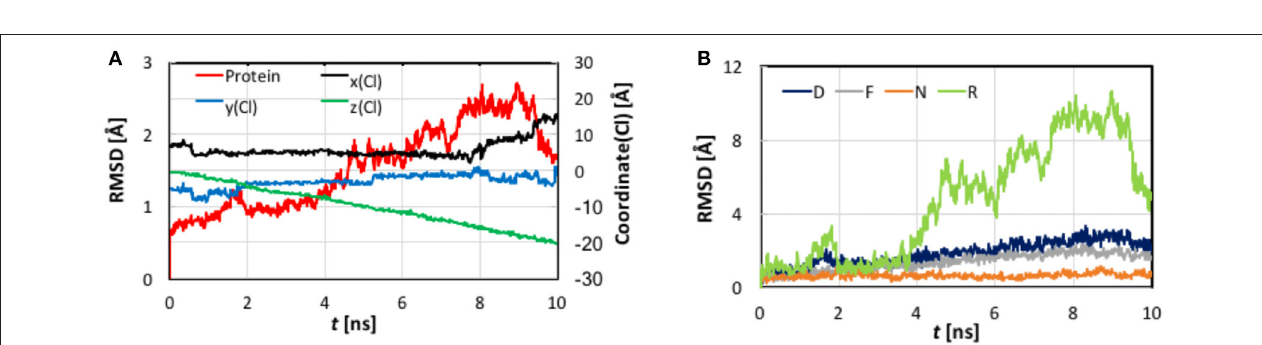
FIGURE 4 | (A) Cartesian coordinates of the transferring Cl − ion and root-mean-square-deviation (RMSD) values of the protein backbone heavy atoms as functions of the simulation time of the steered molecular dynamics simulations with a steering speed of 2 Å/ns. (B) The RMSD values of the helixes D, F, N, and R, which form the